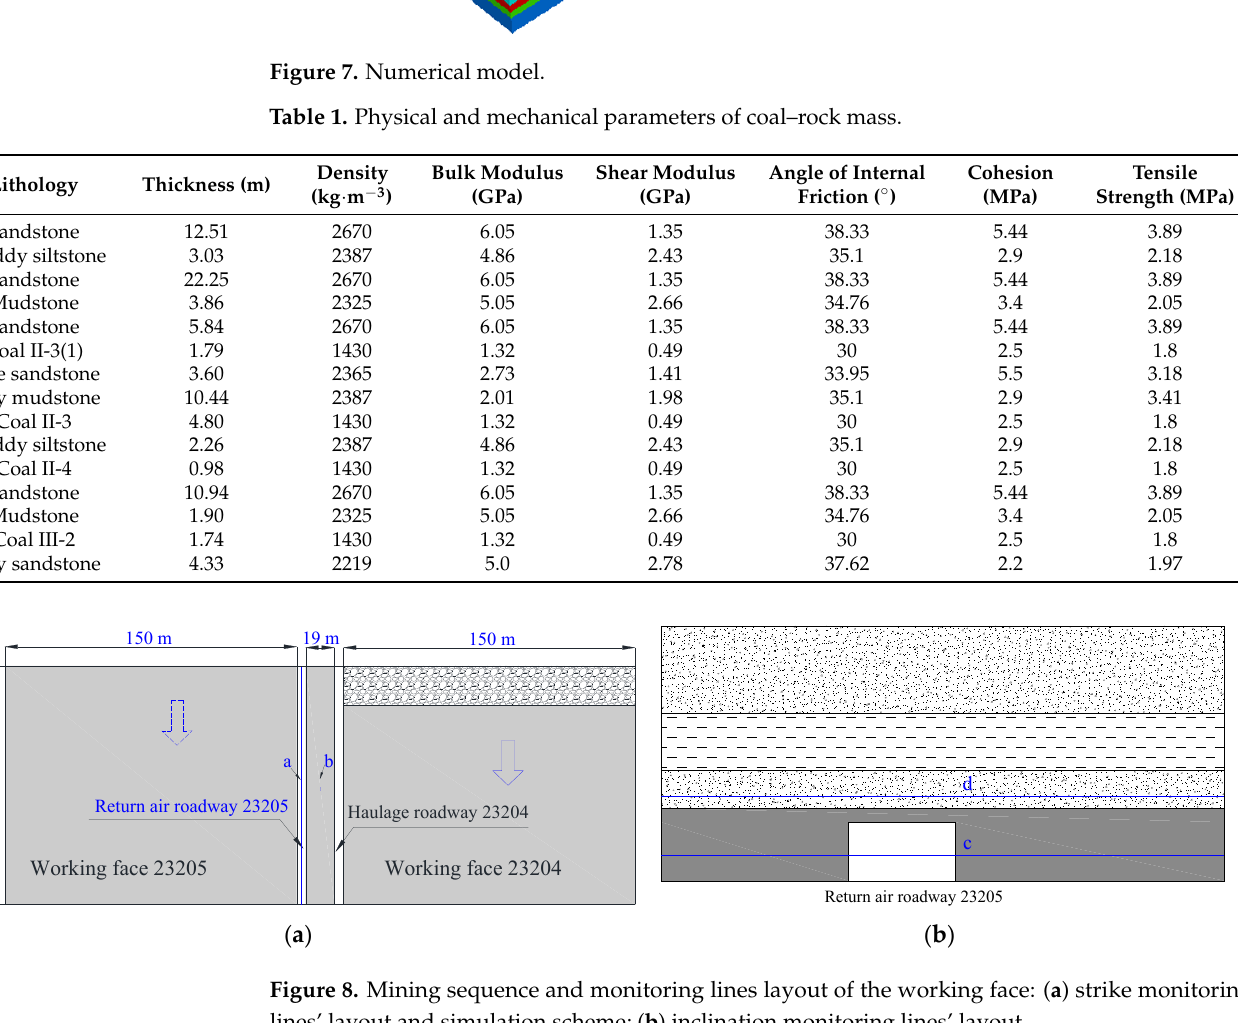
Figure 8. Mining sequence and monitoring lines layout of the working face: ( a ) strike monitoring lines’ layout and simulation scheme; ( b ) inclination monitoring lines’ layout.